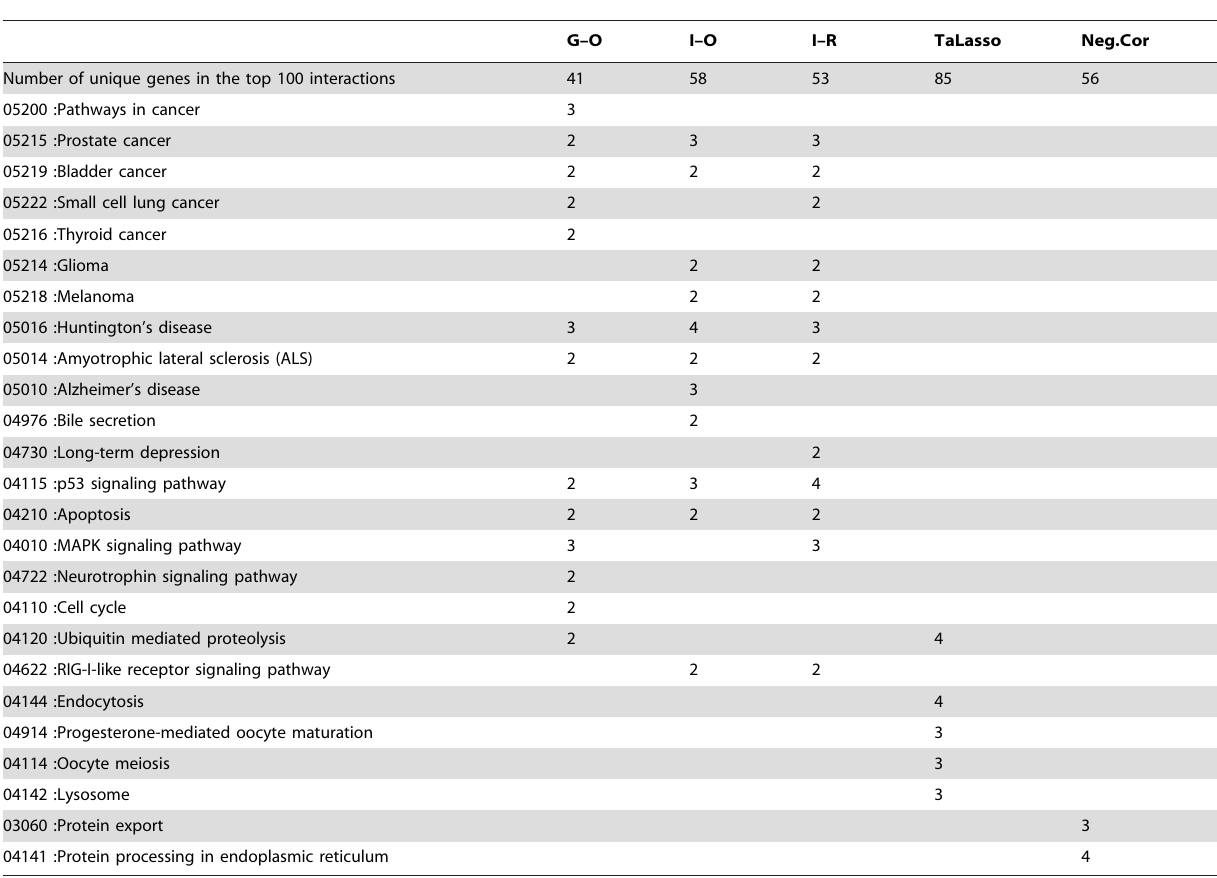
Table 2. Enriched KEGG pathways among genes in the top 100 interactions.